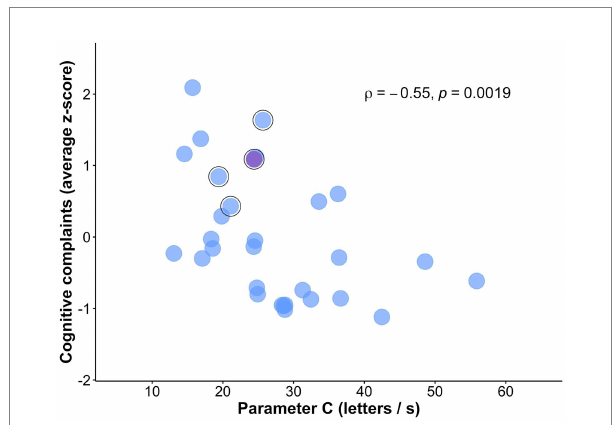
FIGURE 3 Scatterplot of the association between subjective cognitive complaints and visual processing speed C . Relationship between visual processing speed C and subjective cognitive complaints (i.e., z -score averaged across ECog and MFQ total scores). Outlined in black are participants that reported being concerned about their memory in the demographic questionnaire. Marked in violet is the participant who visited a doctor due to those memory